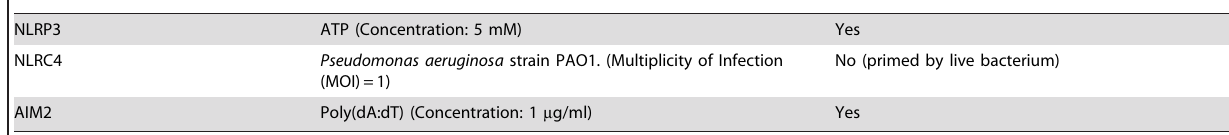
Table 1. Inflammasome Activators.